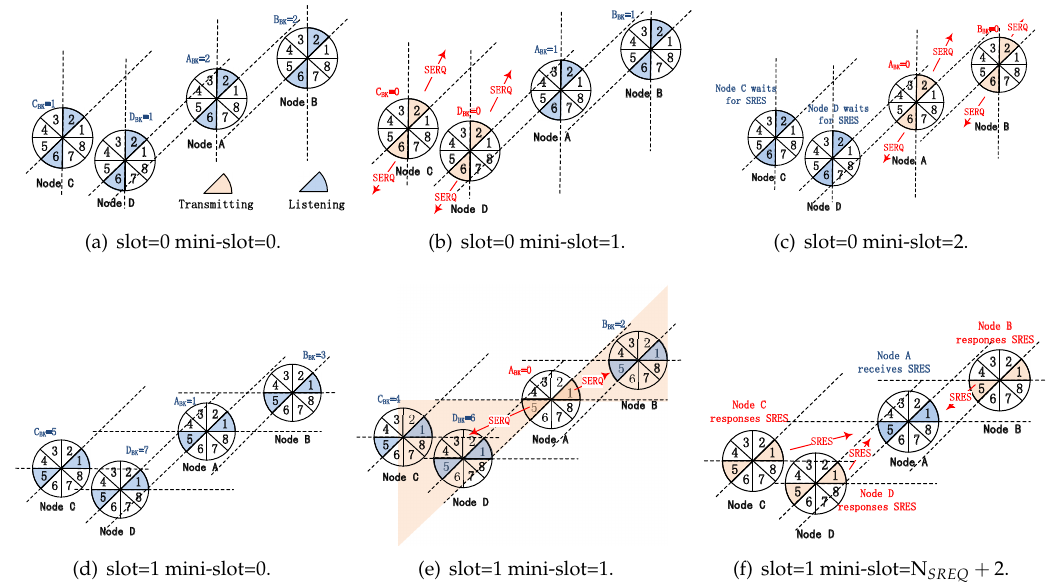
Figure 7. Illustration of BD-SBA